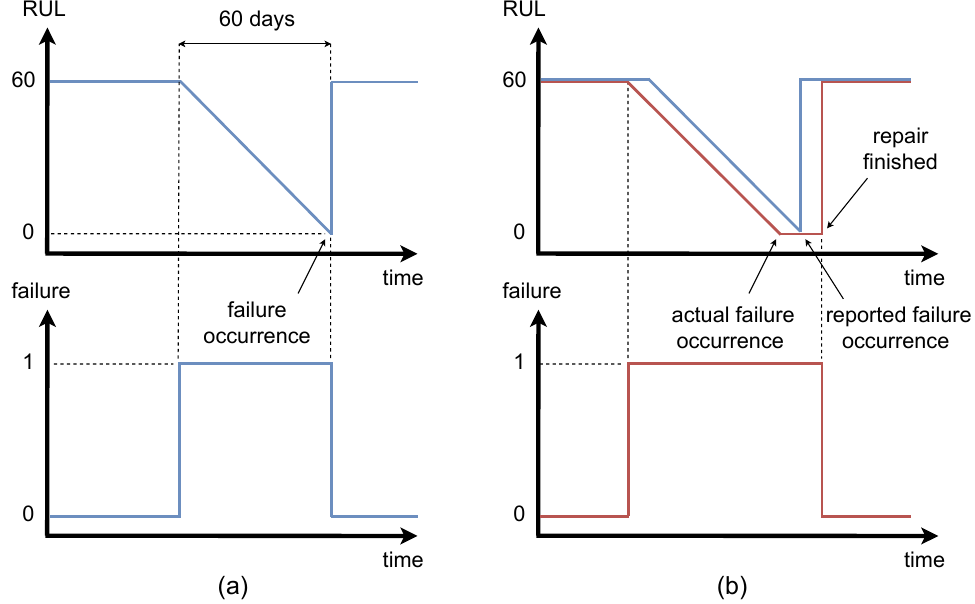
Figure 8. Continuous target variables, ( a ) Initial target variable, ( b ) Improved target